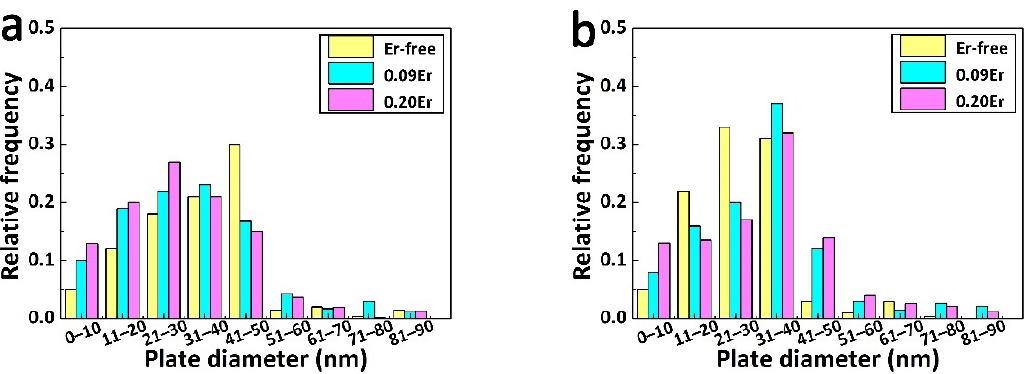
Ω and θ (cid:48) phases of studied alloys. ( a ) Ω phase; ( b ) θ (cid:48) Figure 10. Statistical diagram of the distribution of the Ω and θ′ phases of studied alloys. ( a ) Ω phase; ( b ) θ′ phase. Figure 10. Statistical diagram of the distribution of the